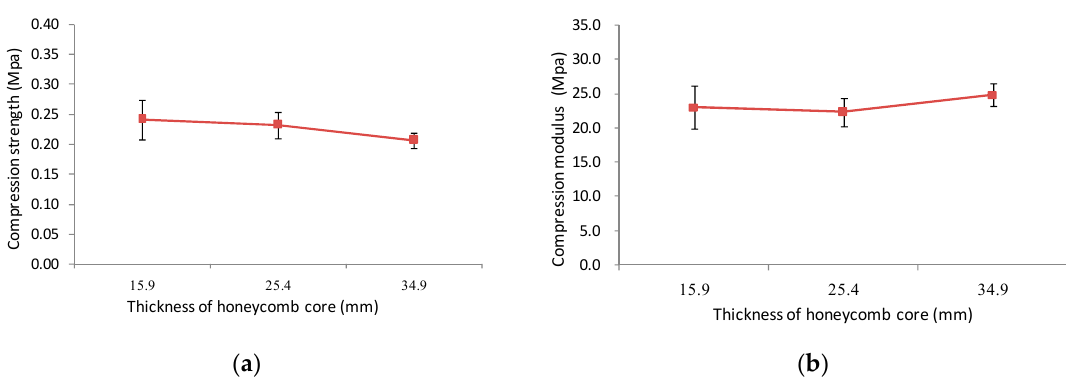
Figure 6. The effect of thickness of the honeycomb core on compression properties: ( a ) compression strength; ( b ) compression modulus (surface sheet: 3.18 mm MDF;loading speed: 0.5mm/min; and vertical bar: error bar with standard deviation).